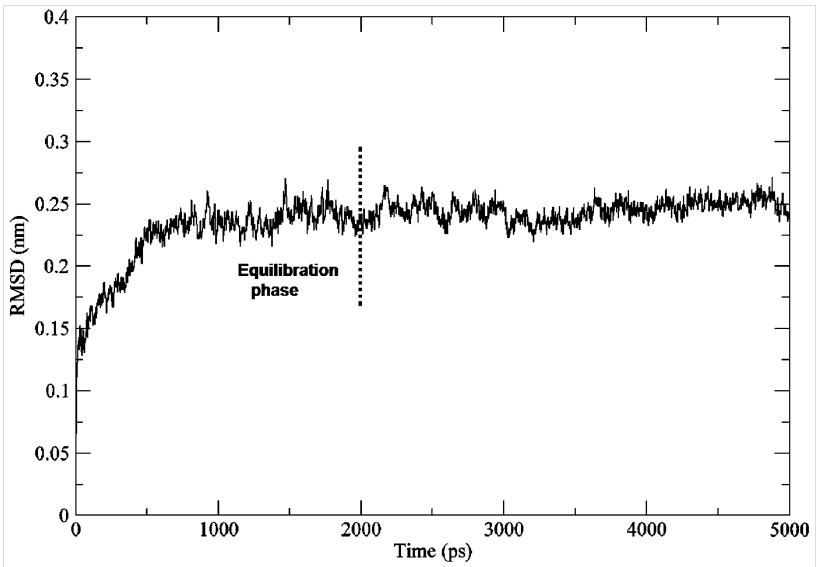
Figure 9. RMSD plot of F.ananassa UGT generated from MDS trajectory. RMSD plot of C a atoms of generated structures of F. ananassa UGT with time shown in ps along X-axis and RMSD values in nm along